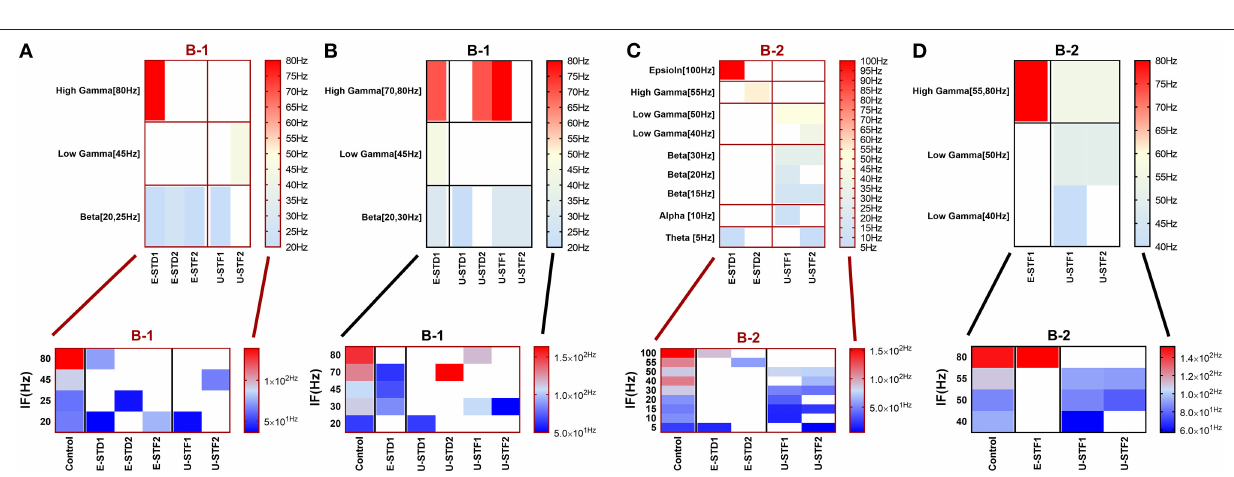
FIGURE 3 | Heat maps of selected elicited responses in each network scenario (B-1) and (B-2), in both immature and mature conditions, respectively, before and after implementing dynamical synapses. (A,C) refer to immature conditions of network scenarios (B-1 and B-2) while (B,D) relate to mature conditions of network scenarios (B-1 and B-2). The upper graphs refer to particular Poisson input frequencies [IF (Hz)] that triggered a substantial modulation effect, measured in Hz before and after STP in these networks (Lower graphs). White blocks refer to excluded values due to statistical variations in probability density function (PDF). Control refers to the condition without STP implementation (dynamical synapses); STD1 and STD2 refer to two types of depressing synapses while STF1 and STF2 refer to facilitating synapses. E-STD1, E-STD1, E-STF1, and E-STF2 relate to the expected modulation effect induced by dynamical synapses, i.e., reduction of firing rate activities in response to depressing synapses (STD1 and STD2) while increasing the firing rate activity in response to facilitating synapses (STF1 and STF2). On the other hand, U-STD1, U-STD1, U-STF1, and U-STF2 relate to the expected modulation effect induced by dynamical synapses, i.e., an increase of firing rate activities in response to depressing synapses (STD1 and STD2), while reduction in the firing rate activity in response to facilitating synapses (STF1 and STF2), see also Tables 5 , 6 .